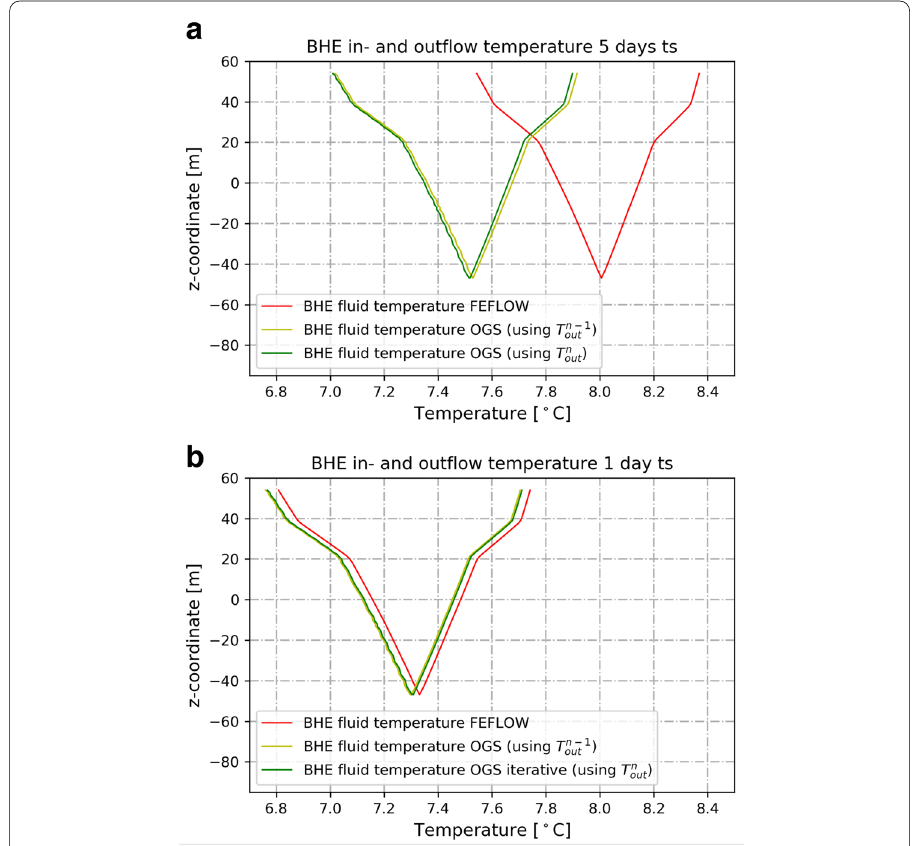
Fig. 7 Vertical temperature distribution for BHE #2 with a 5 days time stepping and b 1 day time stepping